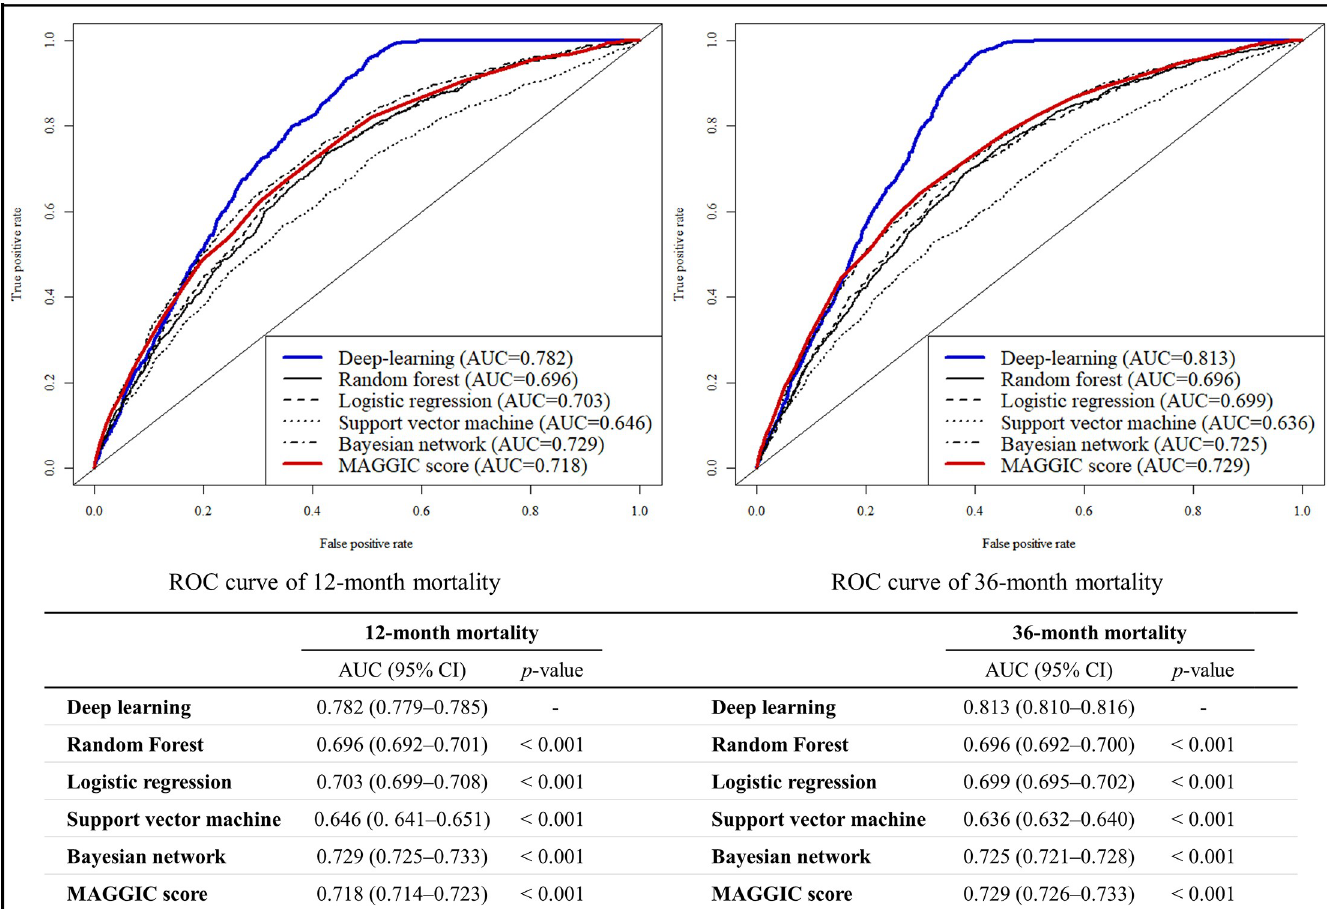
Fig 4. Receiver operating characteristic curves for predicting long-term mortalities. AUC, area under the receiver operating characteristic curve; CI, confidence interval; MAGGIC, Meta-Analysis Global Group in Chronic Heart Failure.